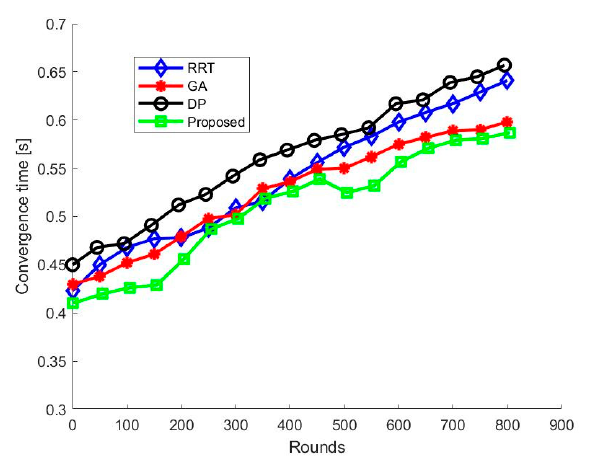
Figure 11. Convergence